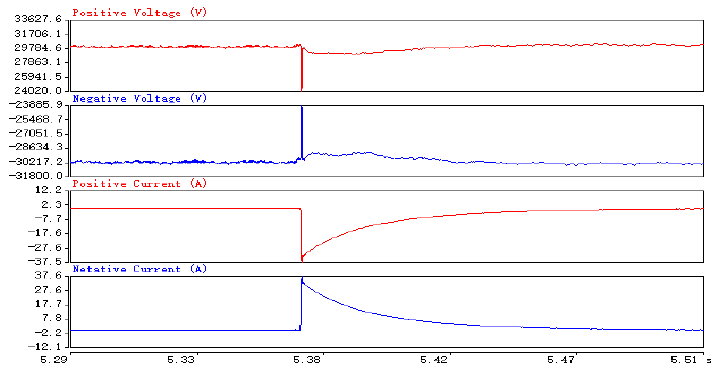
Figure 28. Pre-charging process of the DC/DC converter.